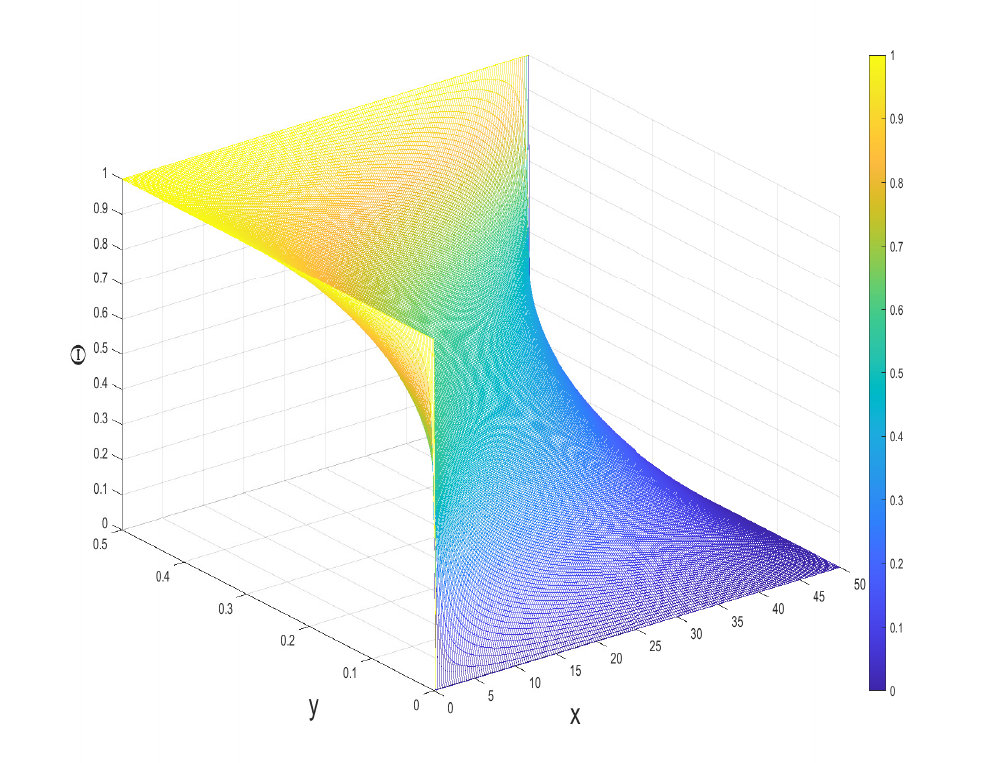
Figure 7. Surface plot of the temperature profile at t =